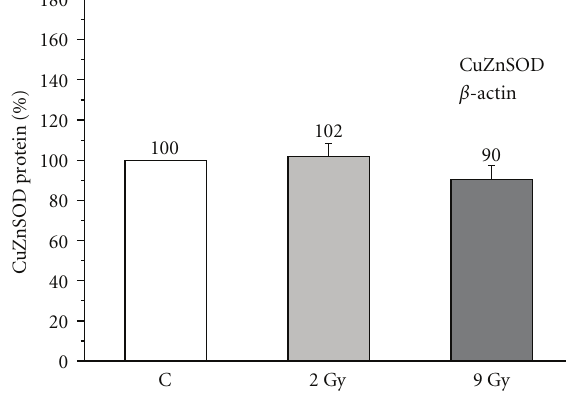
Figure 4: Relative level of CuZnSOD protein in blood cells nonir- radiated (C) and irradiated with 2Gy and 9 Gy of γ -radiation, in healthy women younger than 45 years. Relative values are expressed as percent of value found in the nonirradiated control group, which is considered as 100% (student’s paired t